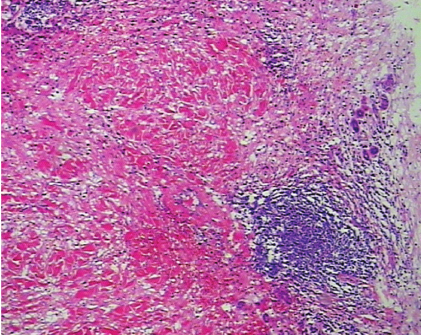
Figure 1: Inflammatory pseudotumor of the right lower limb.